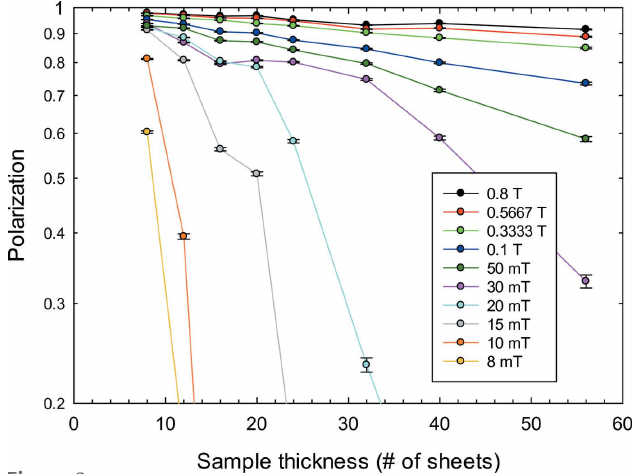
Figure 2 Depolarization of the transmitted neutron beam as a function of the Vitroperm sample thickness at different external magnetic